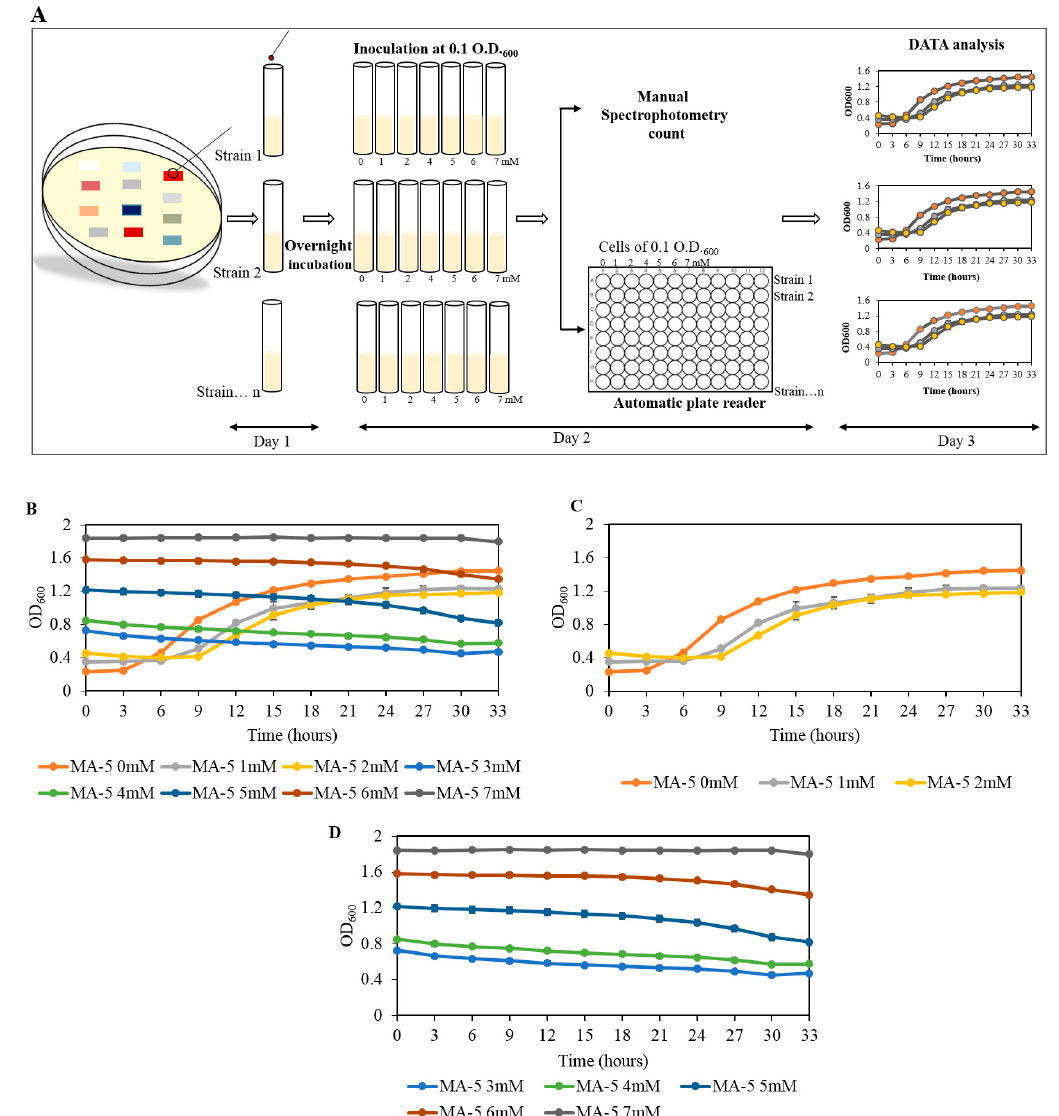
Figure 3. The MIC determination of MA-5, using a spectrophotometric method. ( A ) A schematic shows the steps which were followed in a day-wise manner. ( B ) Represents the growth curve at different concentrations of U. ( C , D ) Represents the growth curve at U concentrations ranging from 0 to 2 mM ( C ) and 3 to 7 mM, respectively ( D ).